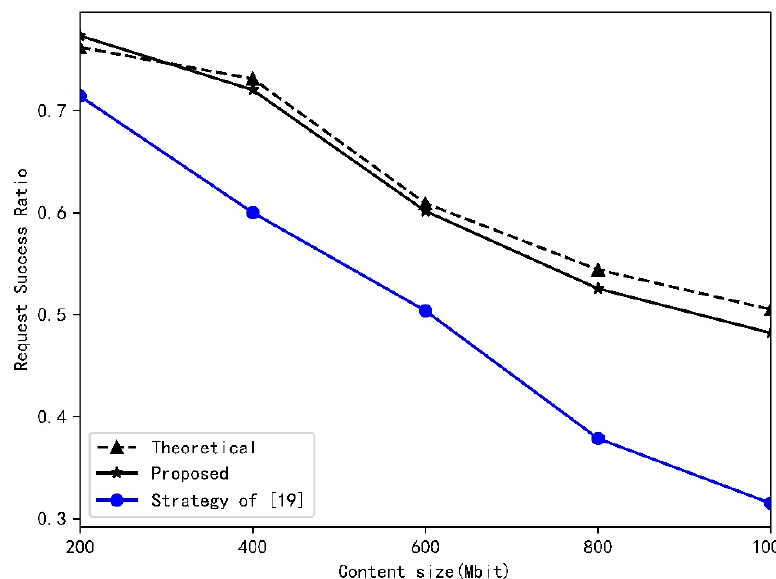
Figure 8. The relationship between the Request Success Ratio and content size.